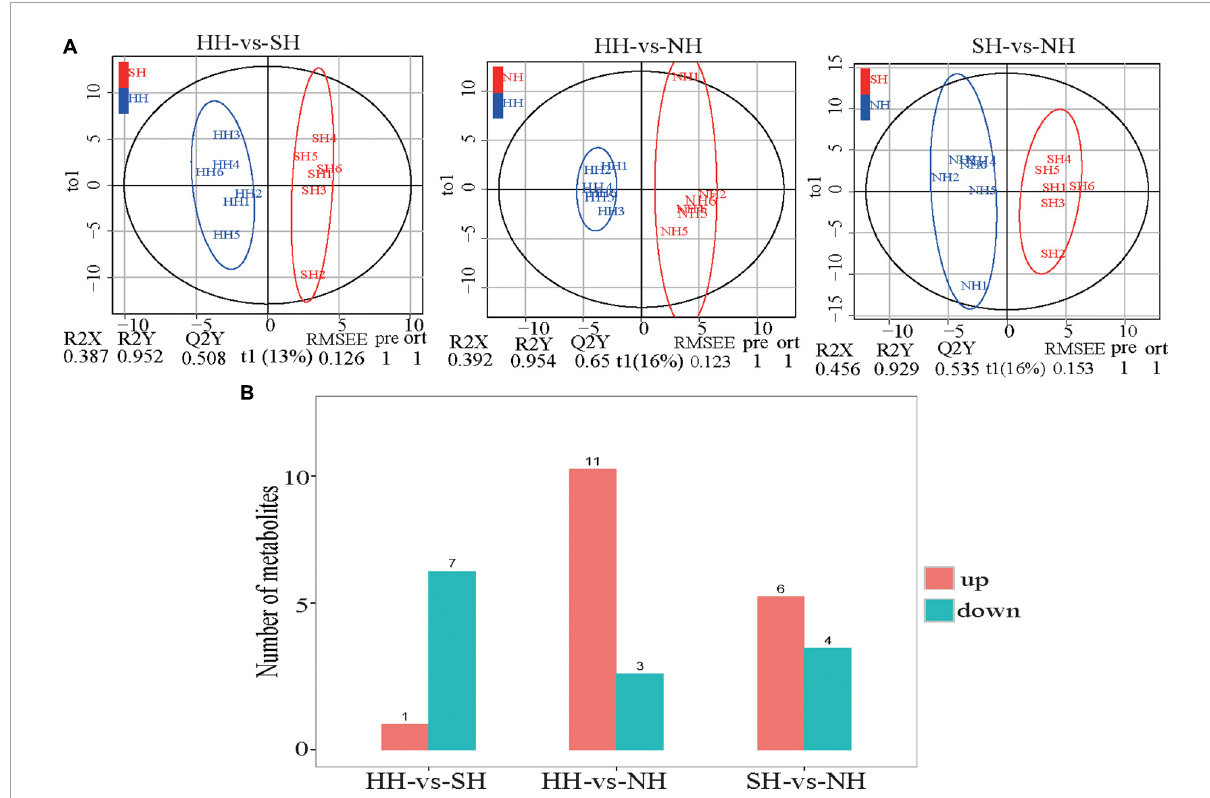
FIGURE5 GC-MS/MS analysis longissimus dorsi metabolic profiles for the HH, SH and NH sheep. (A) OPLS-DA of HH-SH, HH-NH and SH-NH comparisons; (B) Number of up/down-regulated metabolites of different compared groups; red: up-regulated genes; blue: down-regulated